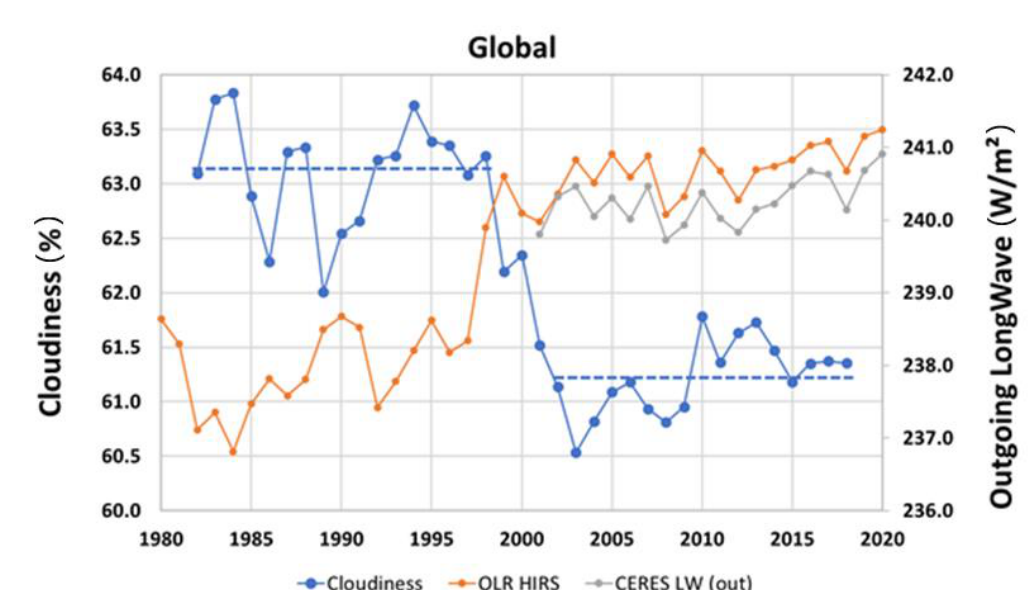
Figure 8. Net flux (TOA) over “ Clear Sky ” ( a ) and “ Cloudy Areas ” ( b ) for global average, NH, and SH. For the global values, the difference between “ Clear Sky ” and “ Cloudy Areas ” is 26 W/m 2 . This 1% change of the cloud cover corresponds to 0.26 W/m 2 flux change.